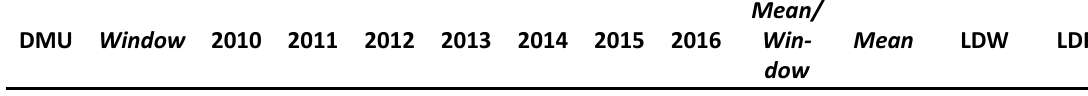
Table 3: DEA Window Analysis Estimation